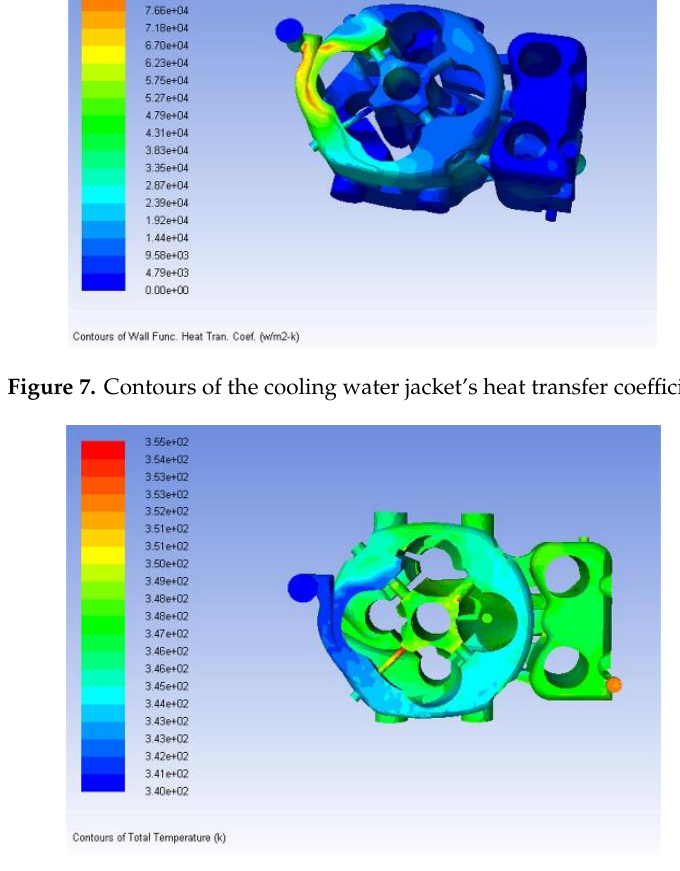
Figure 8. Contours of the cooling water jacket’s temperature.